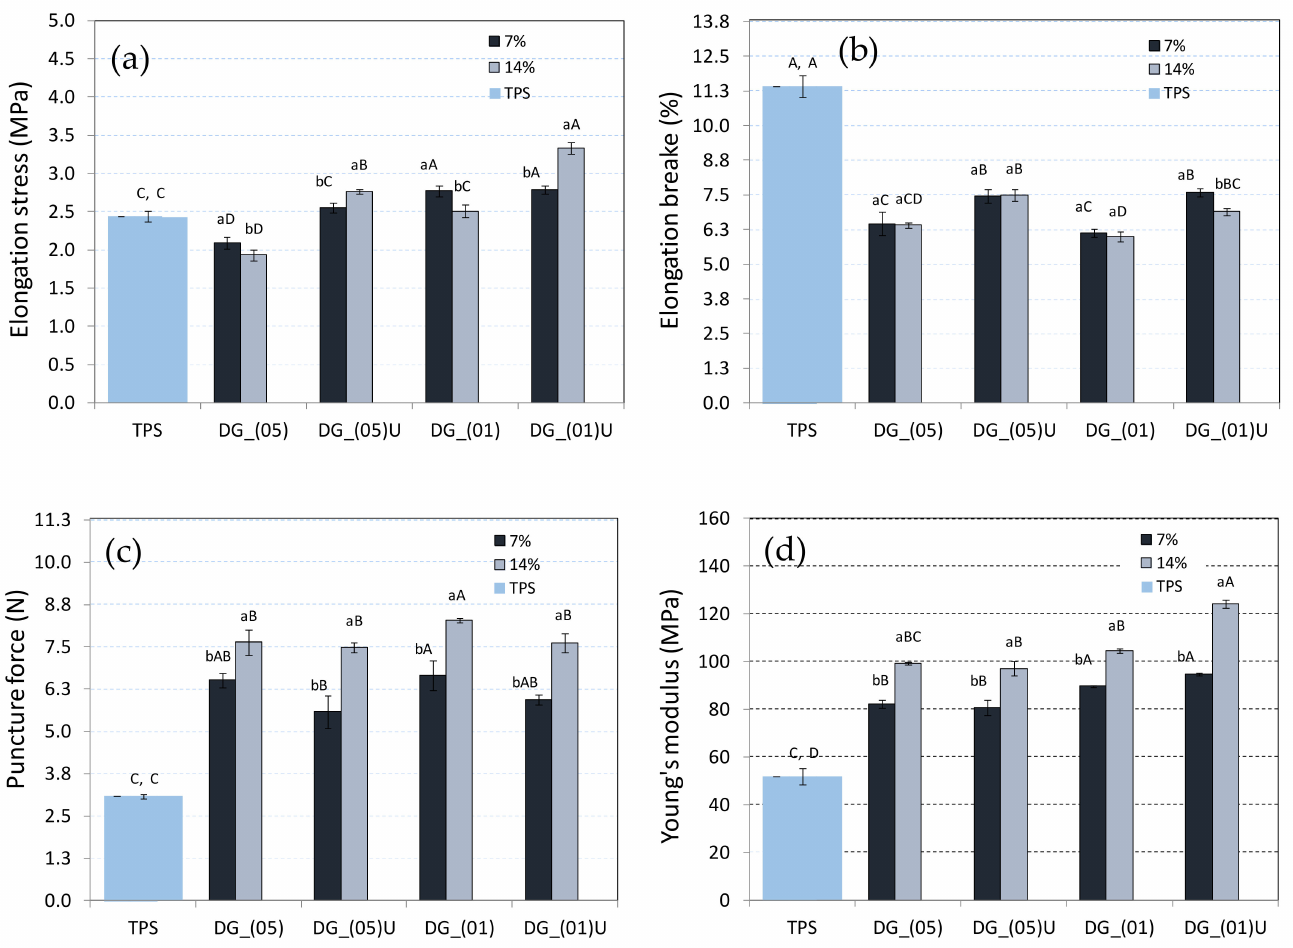
Figure 2. Strength tests of biocomposites: ( a ) elongation stress, ( b ) elongation break, ( c ) puncture force, ( d ) Young’s modulus ( p <